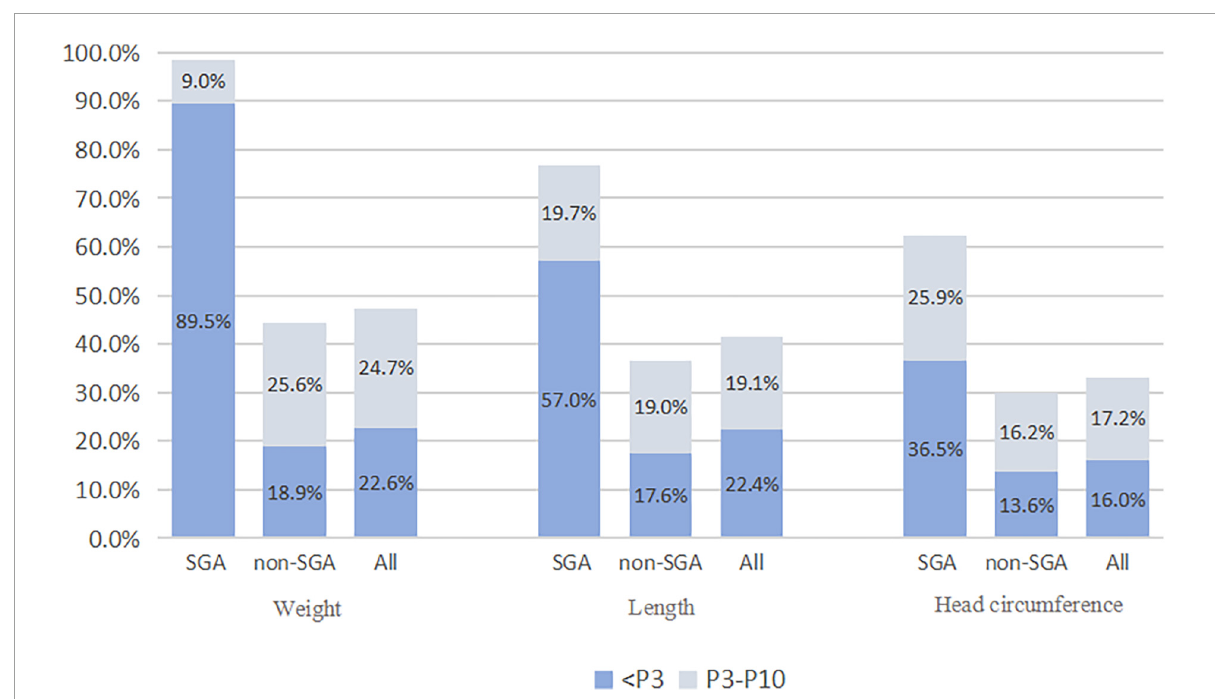
FIGURE2 The incidence of EUGR in SGA and non-SGA infants. SGA, small for gestational age; EUGR, extrauterine growth